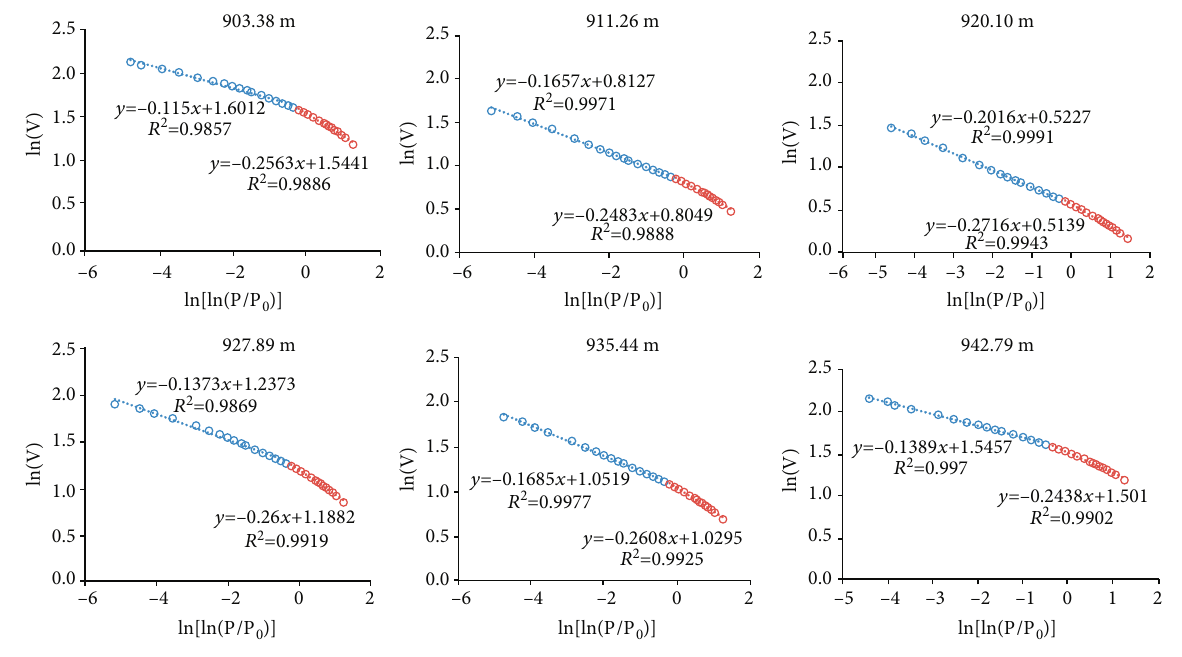
Figure 7: Fitting lines of pore fractal dimensions for the Longmaxi Formation shales. Table 2: Fractal dimensions of the Longmaxi Formation shale from nitrogen adsorption and reservoir characteristic parameters.